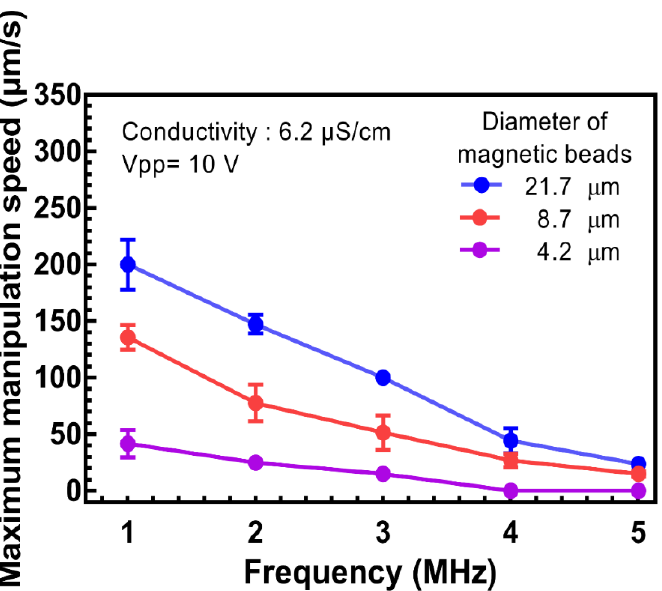
Figure 2. The maximum manipulation speed versus AC trigger frequency with a fixed Vpp of 10 V of magnetic beads with different diameters, including 4.2, 8.7, and 21.7 μm, in a 0.05% BSA solu-